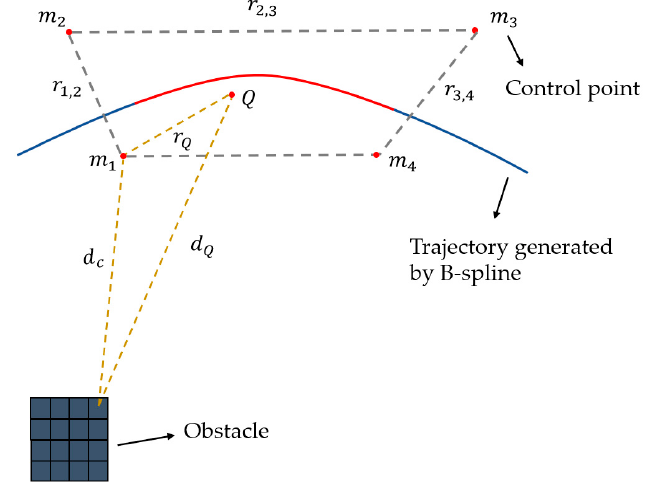
Figure 6. A trajectory (blue line) is represented by a B-spline (k = 4), bounded by the corresponding convex hull of the control points (example convex hulls and segments are shown in gray and red). An illustration of ensuring a convex hull of the B-spline is collision-free.